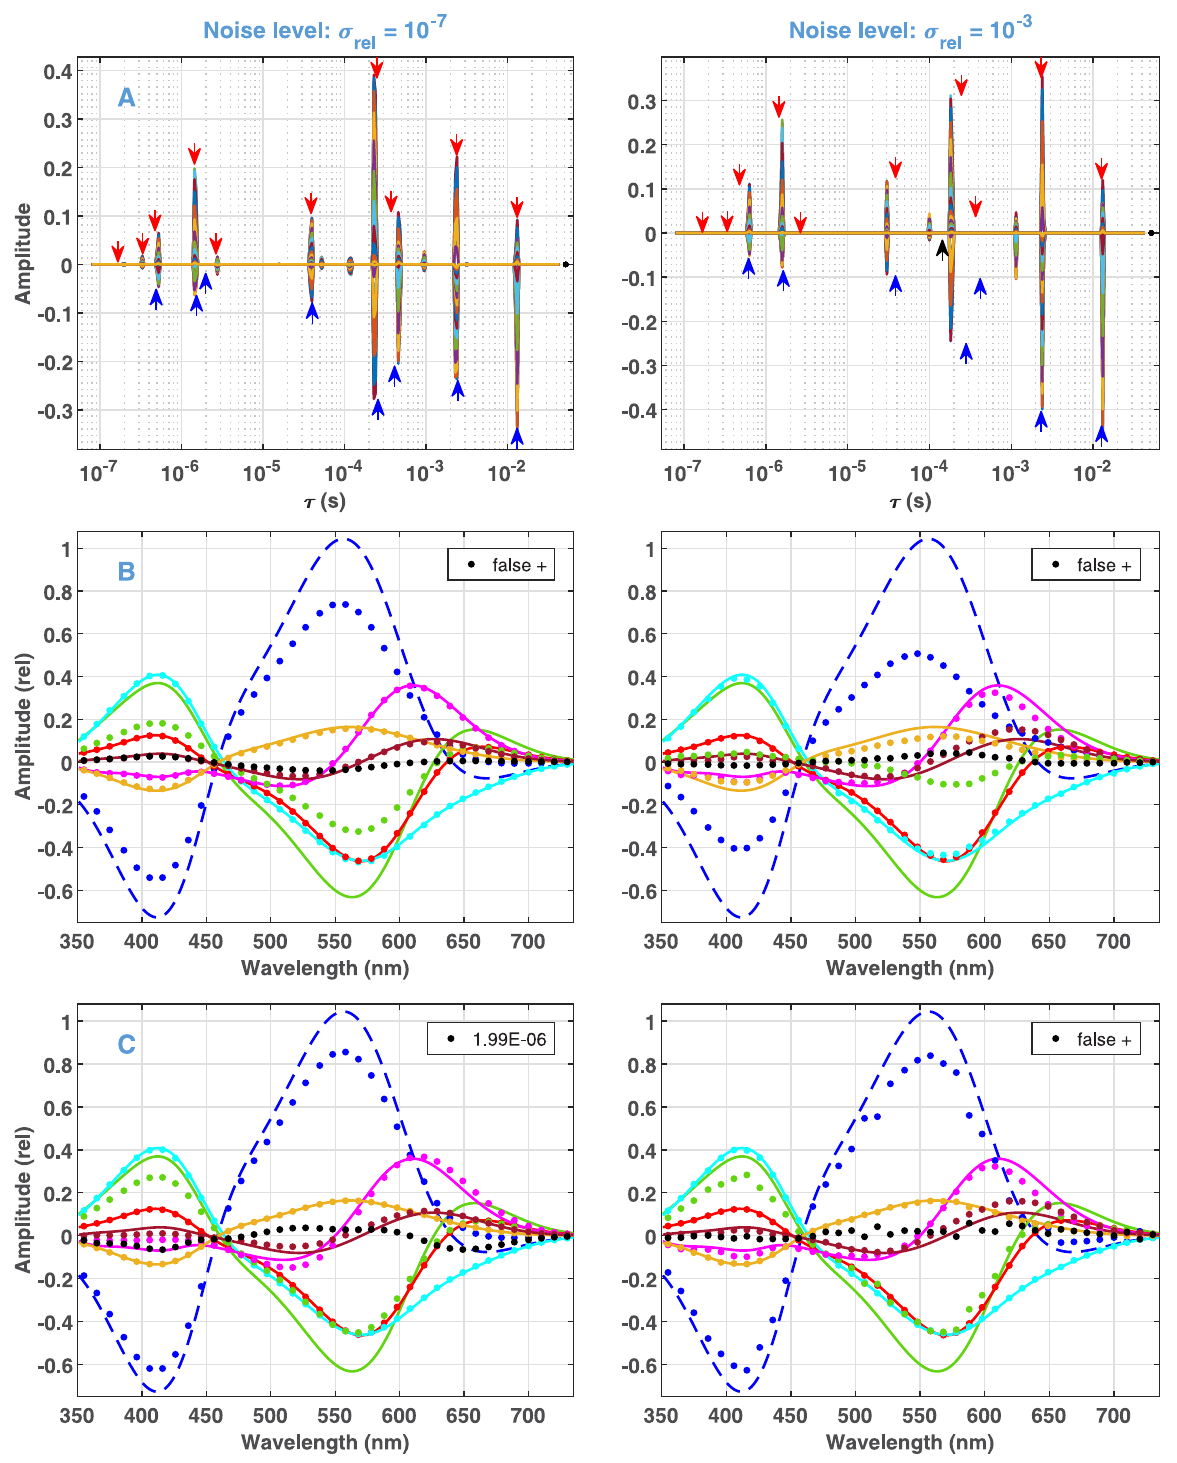
Fig 4. Results of Algorithms 1 and 2 on the selected models presented in Fig 3. (A) Representation over time constants (Algorithm 1, see captions for Fig 2B and 2D for details). The arrows point to the position of the true values (red) and those obtained by Algorithm 2 (valid ones blue, false positive black). (B) Representation by DADSs, neglecting components below 5% of the maximal one (Algorithm 1, dotted) compared to the true DADSs as presented in Fig 1A. (C) DADS obtained by Algorithm 2.